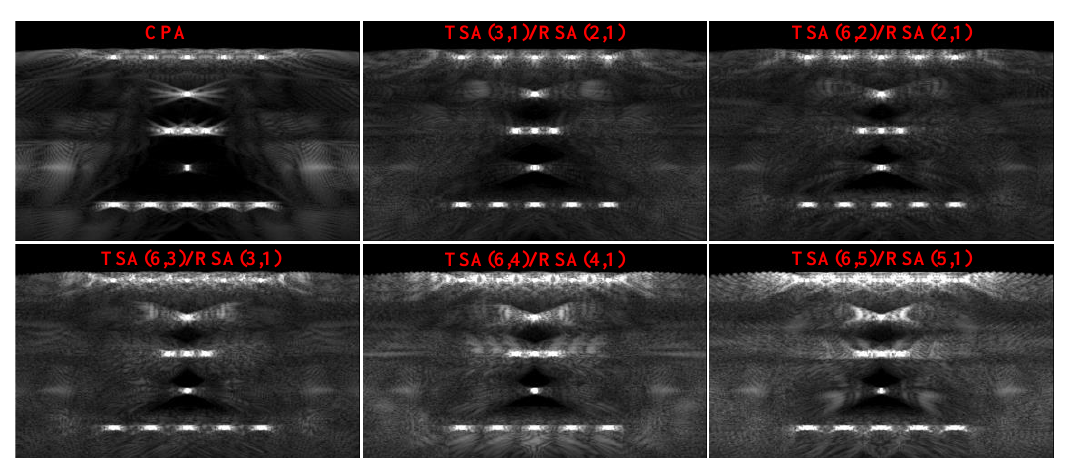
Figure 10. Point targets imaging comparison of SF two − way =